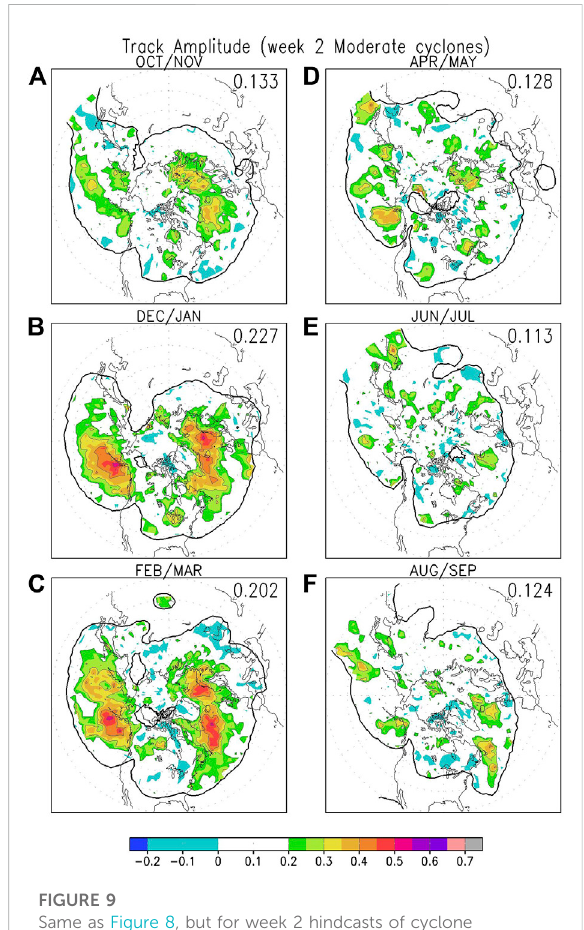
FIGURE 9 Same as Figure 8, but for week 2 hindcasts of cyclone amplitude of moderate